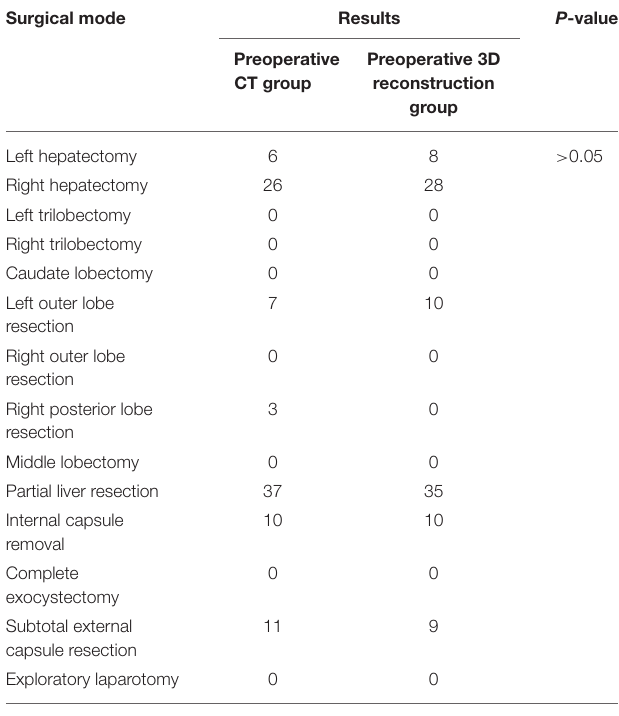
TABLE 3 | Comparison of the surgical mode between the preoperative CT group and the preoperative three-dimensional reconstruction group. Surgical